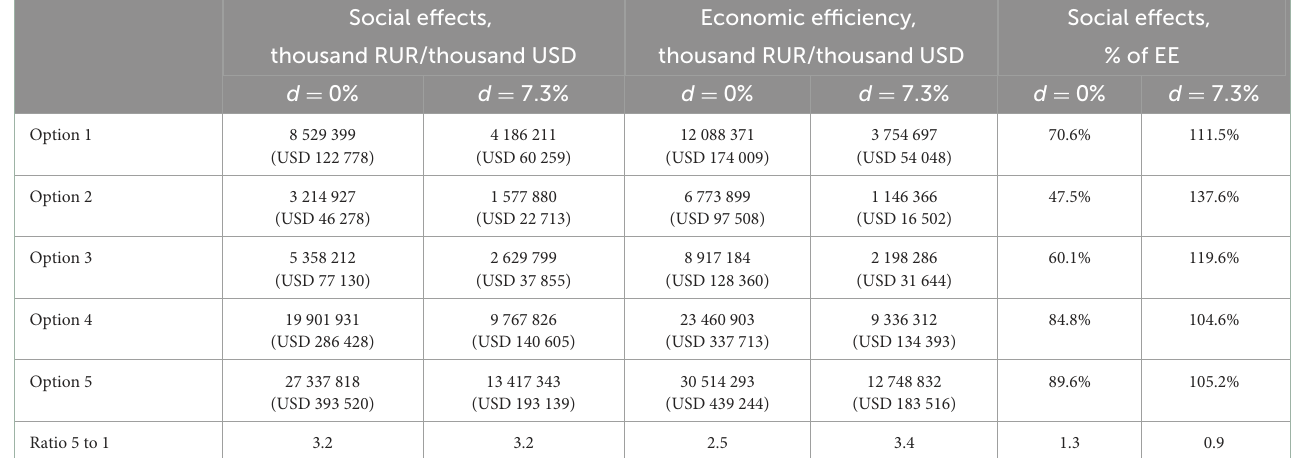
TABLE 6 Social effects and economic efficiency (EE) for the outpatient clinics’ project for the period